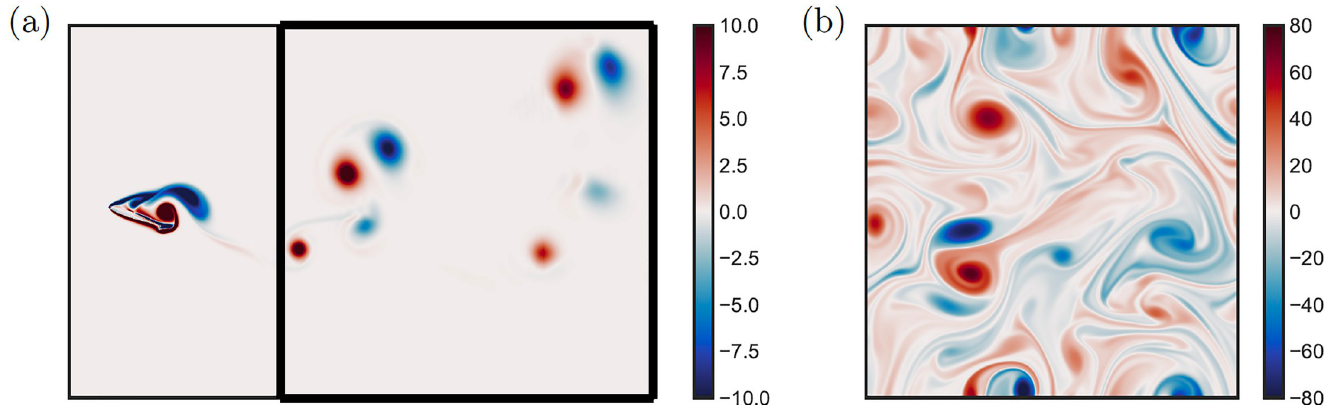
Fig 3. Example flow fields. (a) Vorticity field of two-dimensional DNS of the flow over a NACA 0012 airfoil with Gurney flap at an angle of attack of 20˚ and flap height of 0.1 chord length at Re = 1000; the full illustration can be found in [74]. A subdomain of the original vorticity field is used in this example. (b) Vorticity field of two-dimensional decaying homogeneous isotropic turbulence, initialized by an integral length-scale based Reynolds number of Re ( t 0 ) = 814.